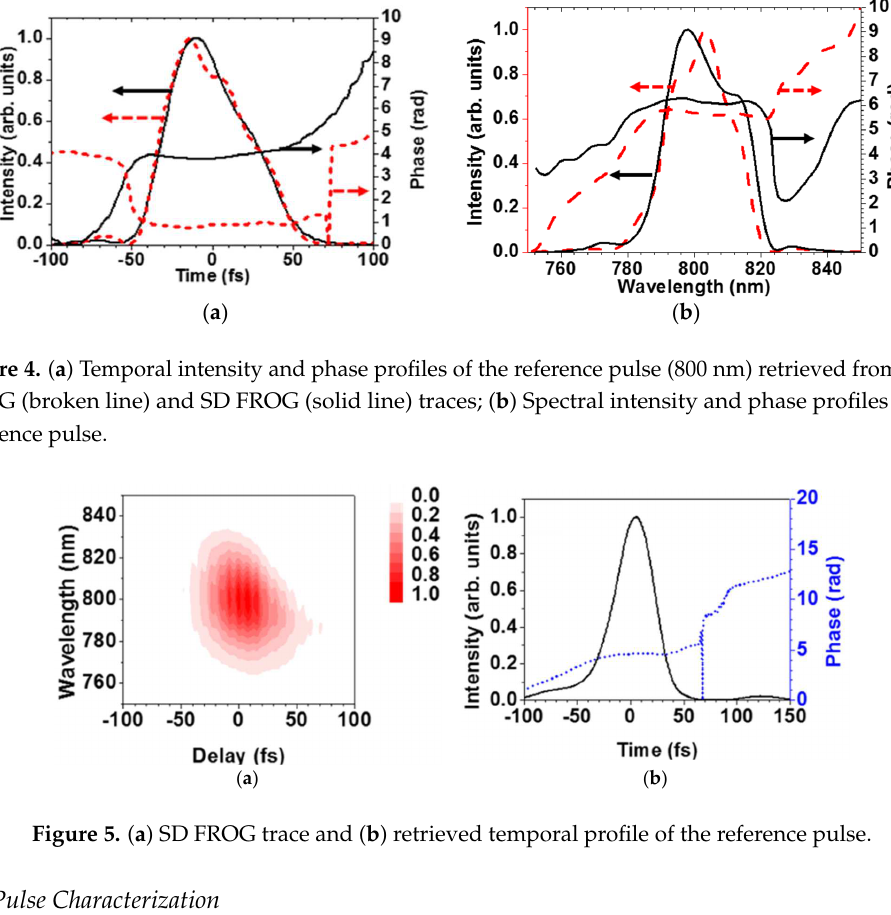
Figure 5. ( a ) SD FROG trace and ( b ) retrieved temporal profile of the reference pulse.